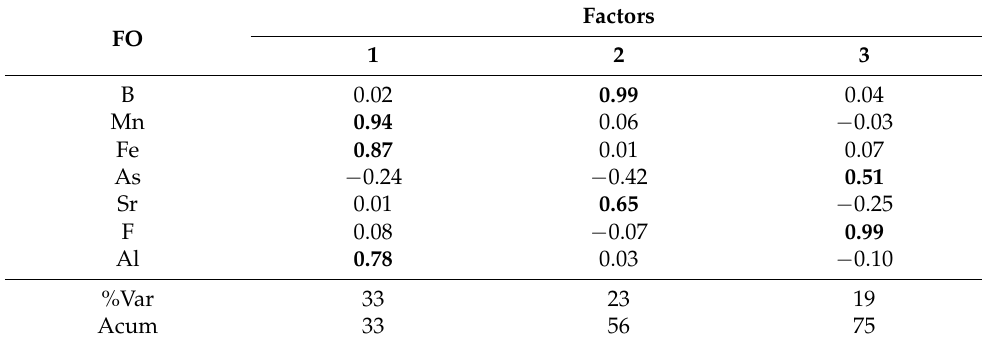
Table 2. Factors using trace